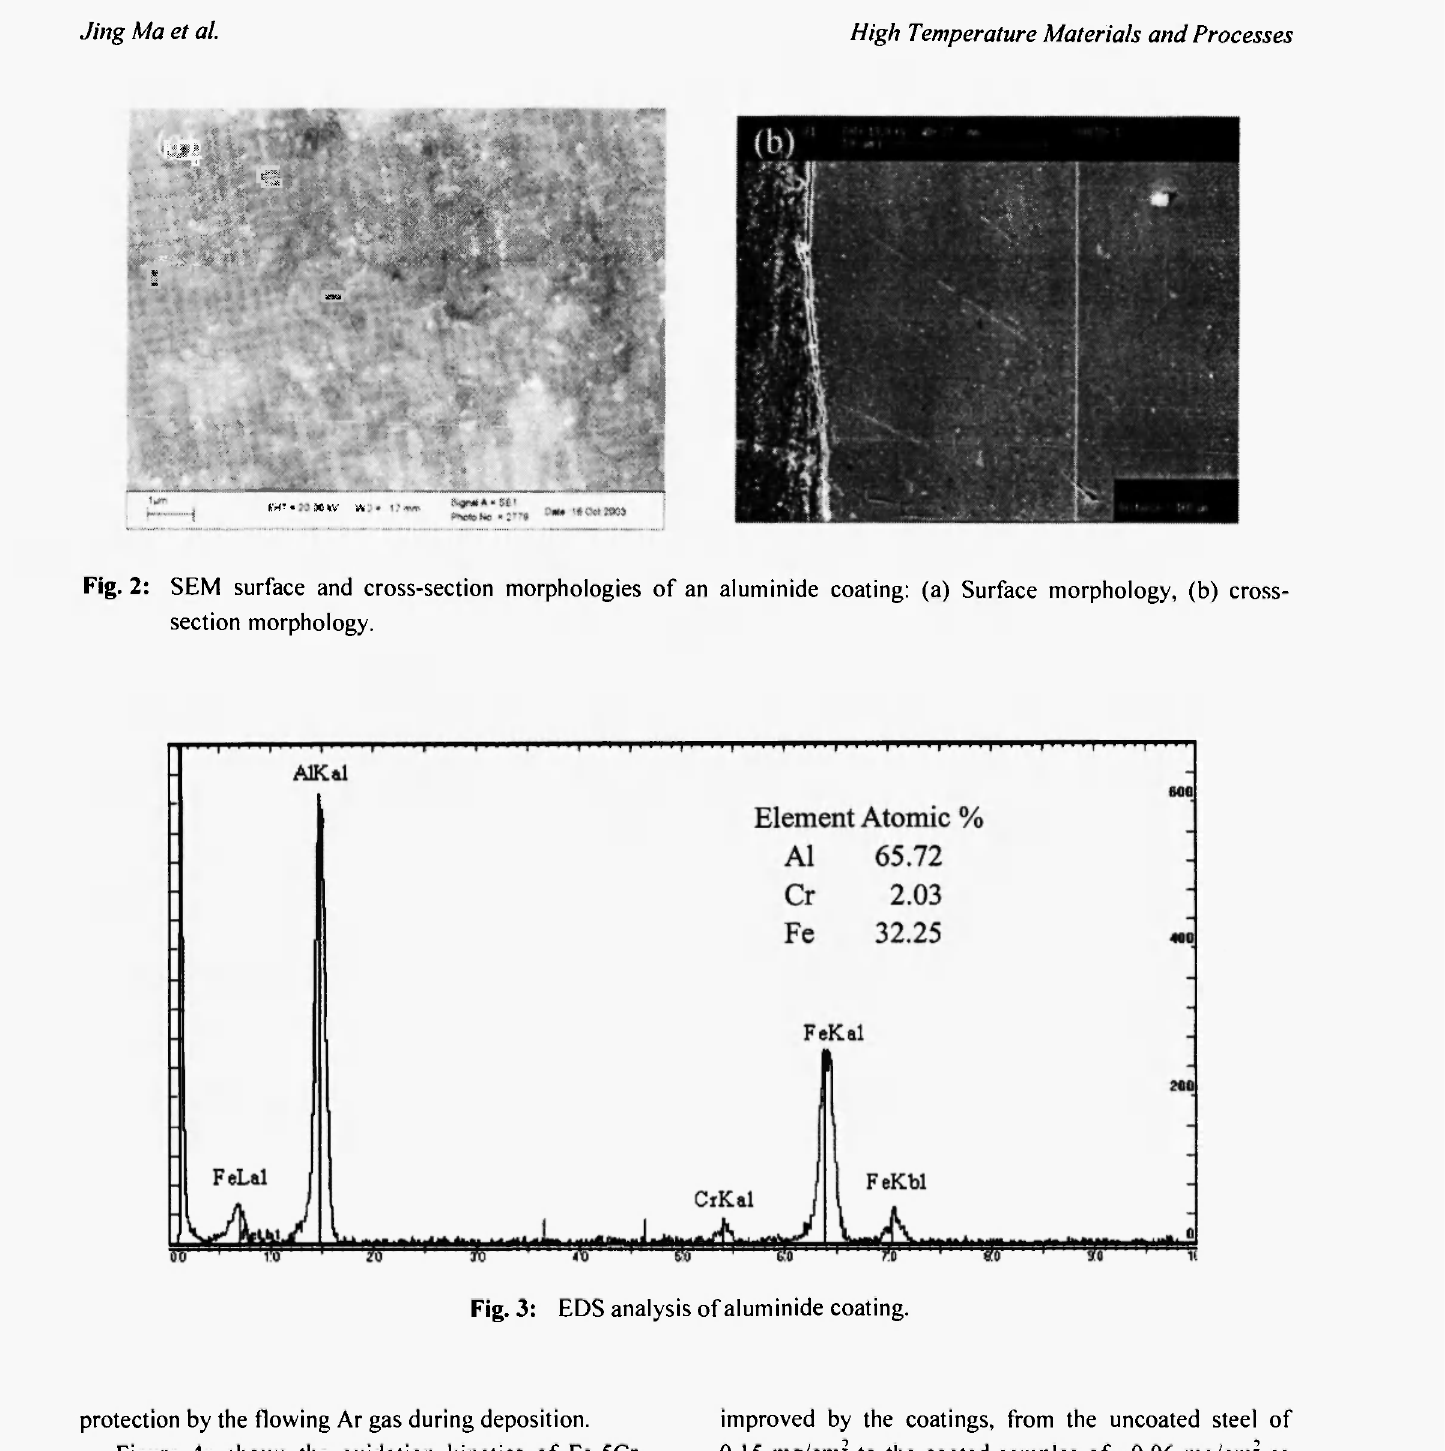
Fig. 3: EDS analysis of aluminide